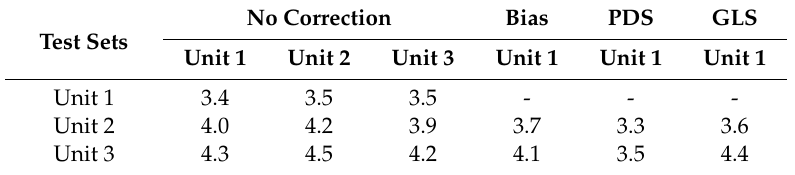
Table 3. The normalized root mean square error of prediction (NRMSEP, %) for ASA.